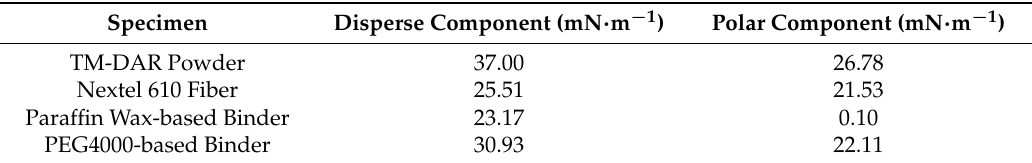
Table 4. The surface energies calculated from the measured contact angles for the individual samples, including polar and disperse components.